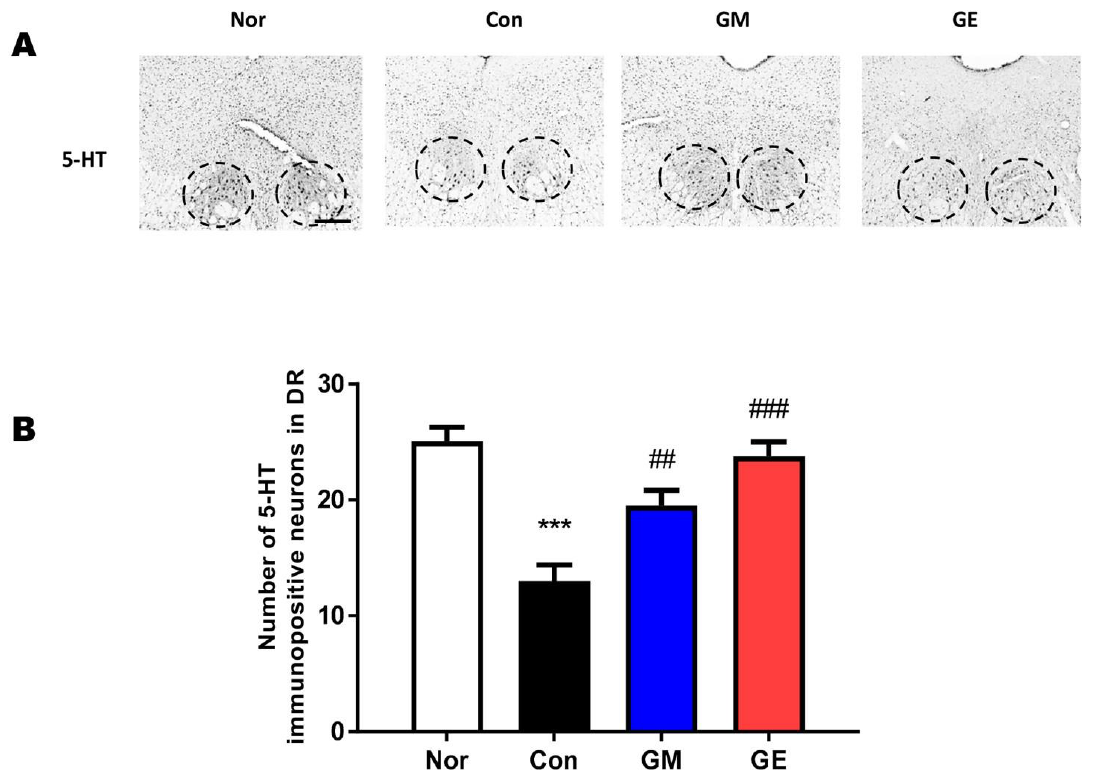
Figure 5. Effect of GM and GE on 5-HT-positive cells in the DRN. ( A ) Photomicrographs of 5-HT- positive cells in the DRN. ( B ) Number of 5-HT-positive cells in the DRN. *** p < 0.001 vs. No (no stress); ## p < 0.01, ### p < 0.001, vs. control (saline with EFS); one-way ANOVA followed by Tukey’s test. Normal (n = 12), control (n = 12), GM (n = 12), GE (n = 12). ). The scale bar represents 100 µm.